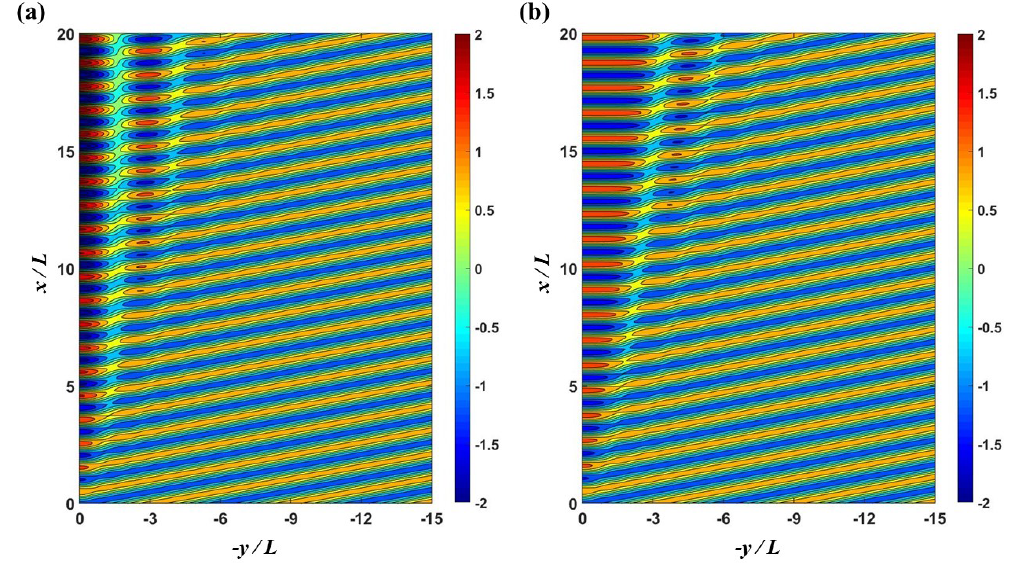
Figure 10. Contour plots of the instantaneous normalized free surface for (a) MLS1 and (b) MLL1 cases from simulation.